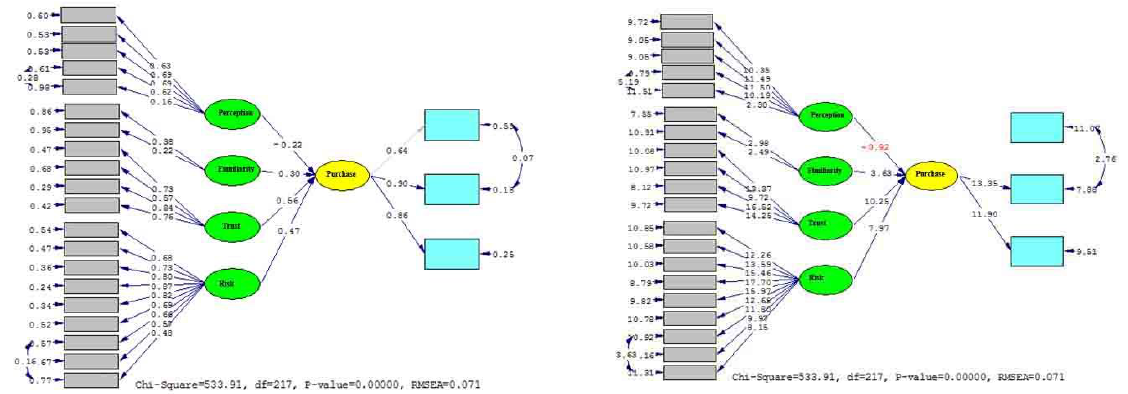
Fig. 2. The results of structural equation modeling as well as standard coefficients